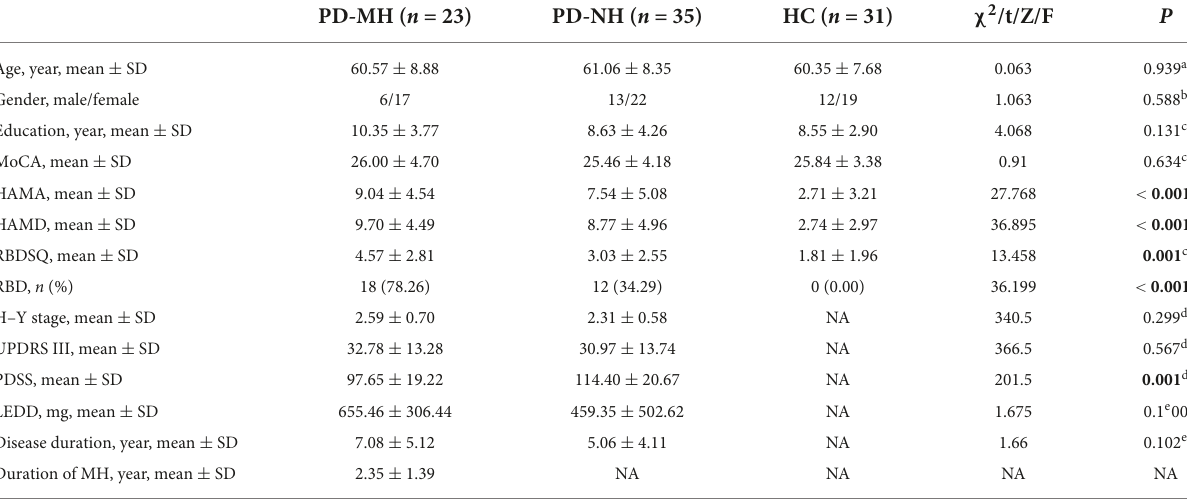
TABLE 1 Comparison of demographic information and scale